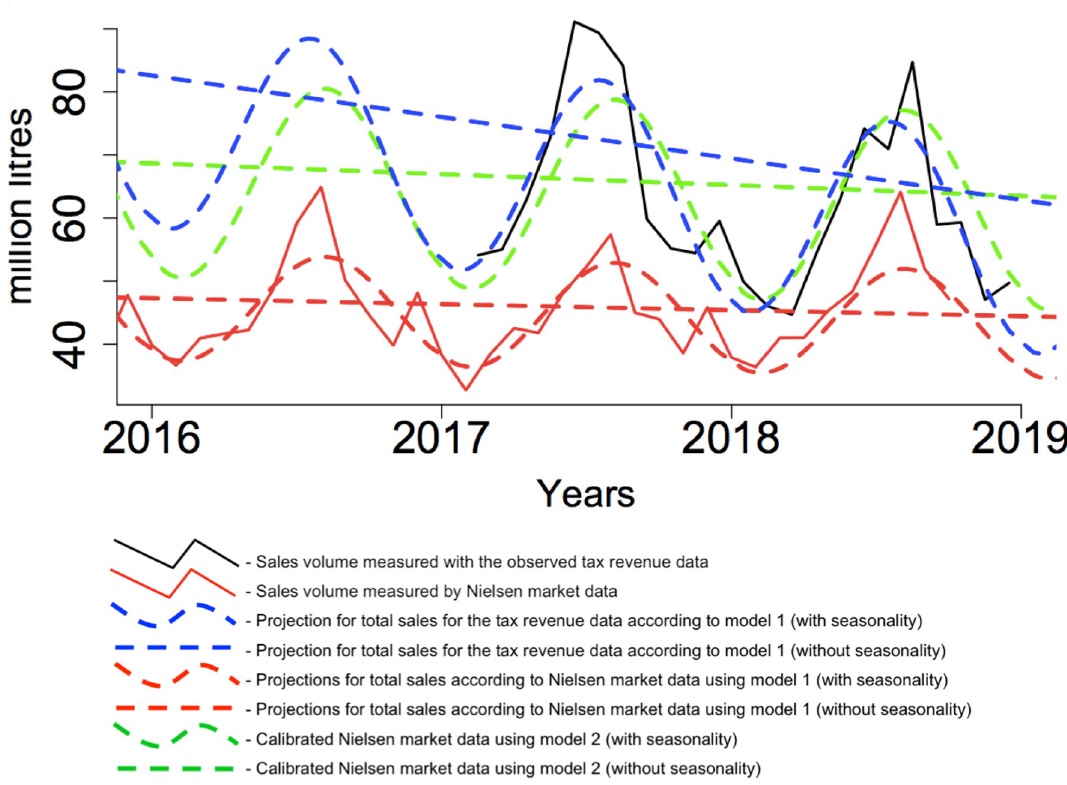
Fig 2. Time trend of total sales of sugar-sweetened beverages according to different data sources. Time trend of sales of sugar- sweetened beverages measured with the observed tax revenue data, only available post-tax (solid black line), and measured by Nielsen market data, available for the entire period 2016–2018 (red solid line); projections for total sales from the tax revenue data according to model 1 (dashed blue line with and without seasonality), projections for total sales according to market data using model 1 (dashed red line with and without seasonality); and calibrated Nielsen data from model 2 (dashed green line with and without seasonality). Dashed curves represent the data with seasonality, while straight lines represent the data without